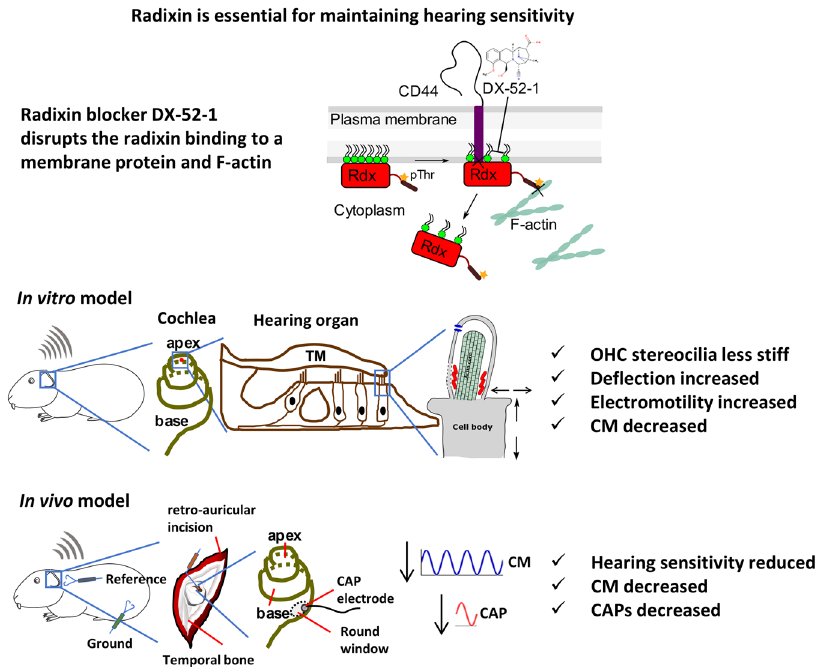
Fig. 9 Radixin is required for maintaining the mechanical stability of stereocilia, the function of mechanically sensitive ion channels, and hearing sensitivity. Schematic diagram of outer hair cell stereocilia with radixin-binding area showing the molecular interactions between radixin and F-actin cytoskeleton, the transmembrane protein CD 44, and the blocker mode of action. In the hearing organ of animals where the radixin blocker DX-52-1 was not applied, the animals had normal hearing and stereocilia functions. Application of the blocker results in a disruption of the link between radixin and F- actin cytoskeleton. The animal had reduced hearing sensitivity, and large effects on OHC stereocilia functions were